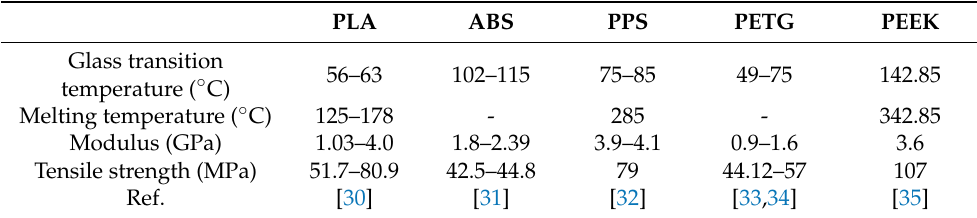
Table 1. Physical and mechanical properties of polymers used in the fabrication of impellers.